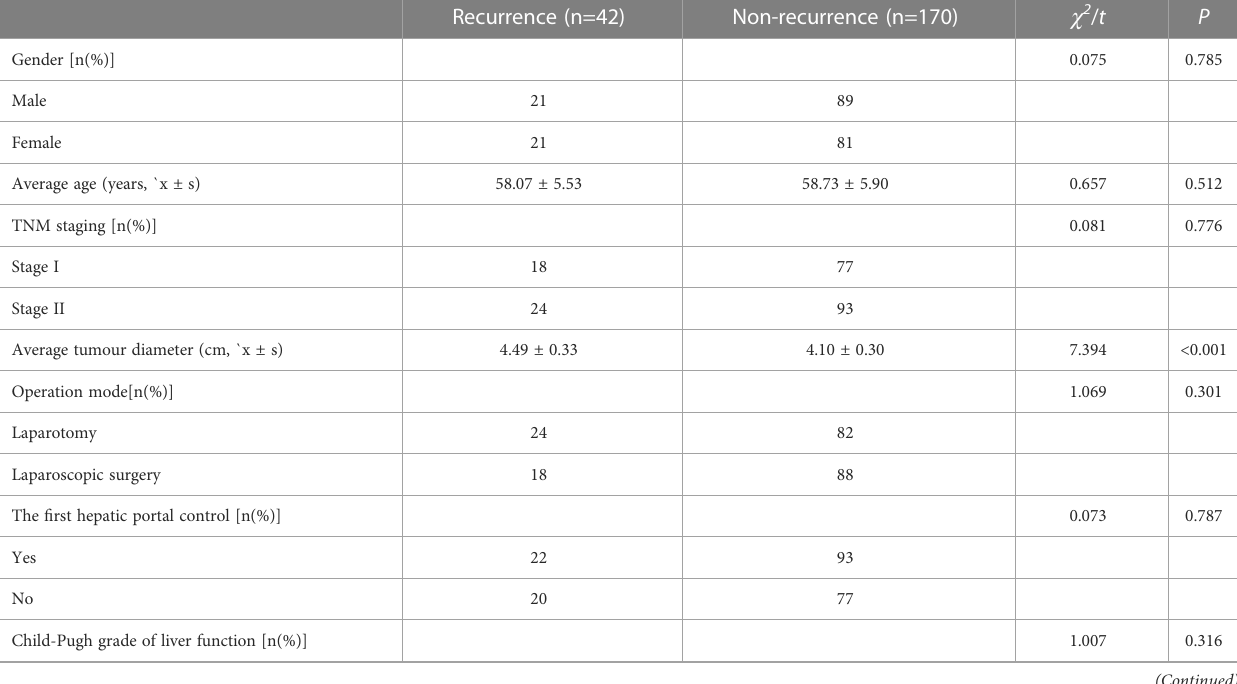
TABLE 4 The related factors of postoperative